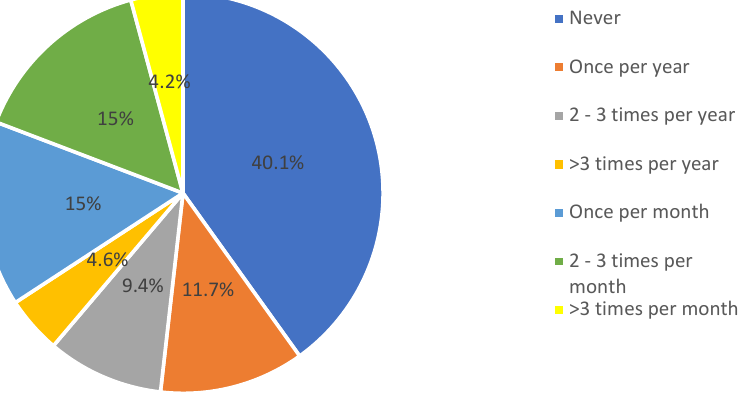
Figure 1. How often do you see a patient on insulin pump?